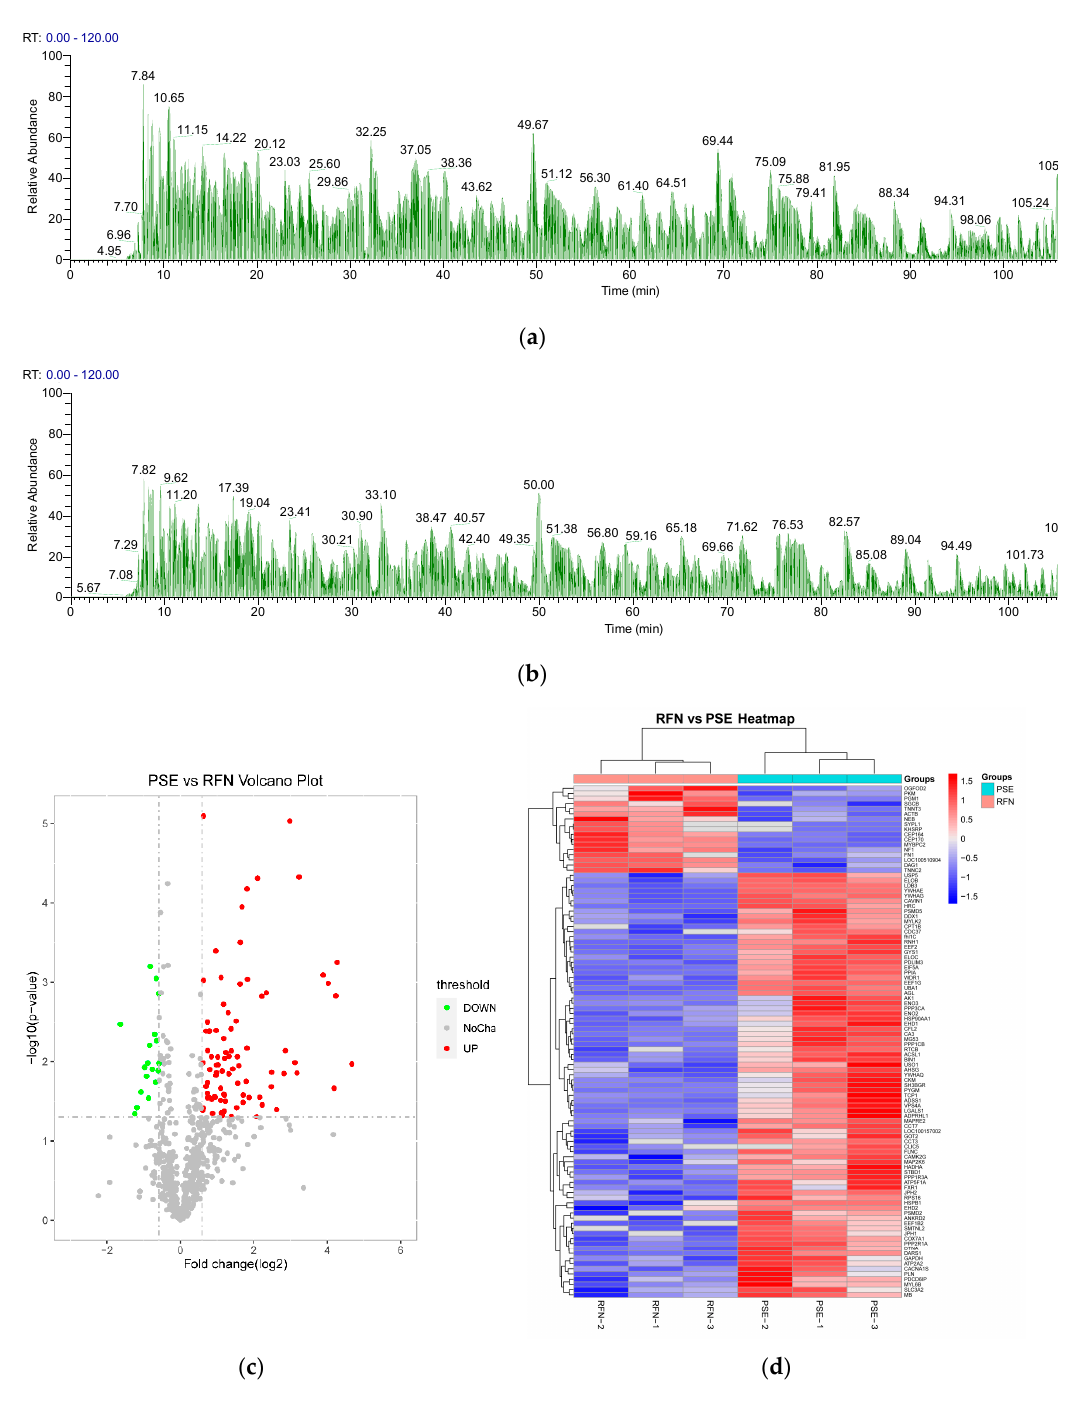
Figure 3. ( a ) Representative mass spectrometry (MS) base peak chromatogram of the myofibrillar protein extracted from RFN meat by nLC-nESI-HRMS; ( b ) representatively MS base peak chromatogram of the myofibrillar protein extracted from PSE meat by nLC-nESI-HRMS; ( c ) comparison of the differential proteins between the pale, soft and exudative (PSE), and red, firm and non-exudative (RFN) groups, as shown in the volcano plot; ( d ) heatmap with the difference FC > 1.5 or < 0.667 and a p <